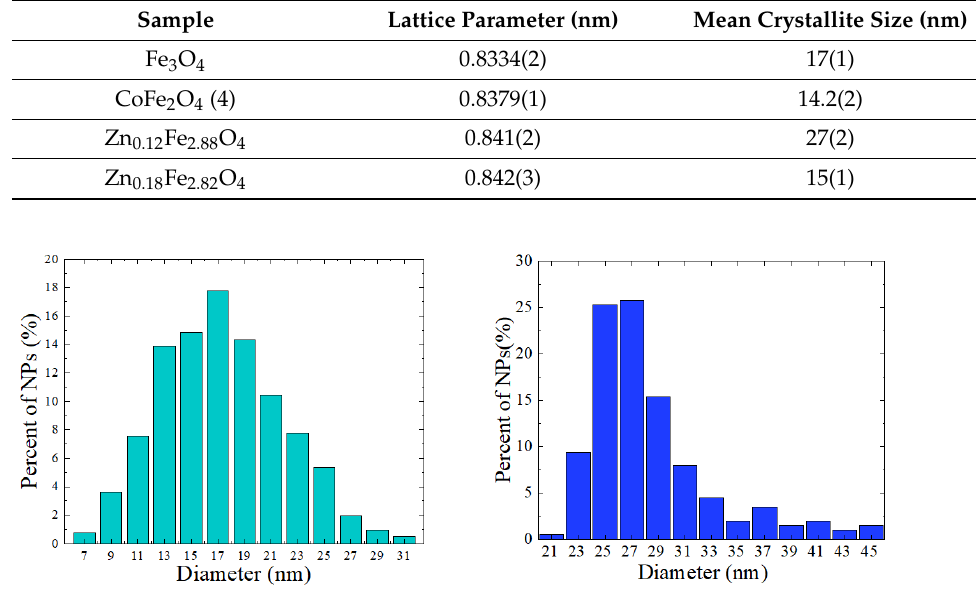
Figure 1. The size distributions for: Fe 3 O 4 ( left ) and Zn 0.12 Fe 2.88 O 4 ( right ) nanoparticles. Table 1. Lattice parameters and nanocrystallite